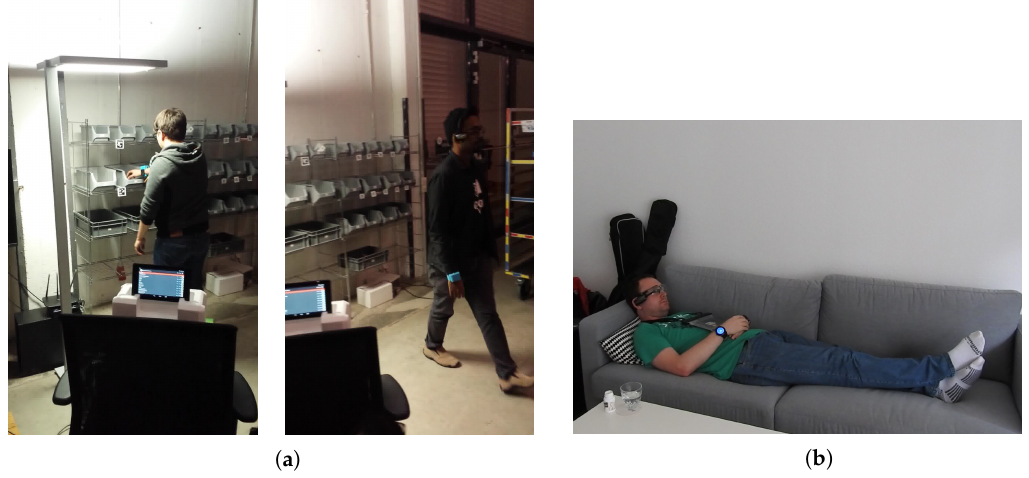
Figure 2. Photos from the recording processes of our datasets. ( a ) Picking scenario. Participant walking towards and away from shelves; ( b ) ADL scenario. A glass of water and pillbox on the